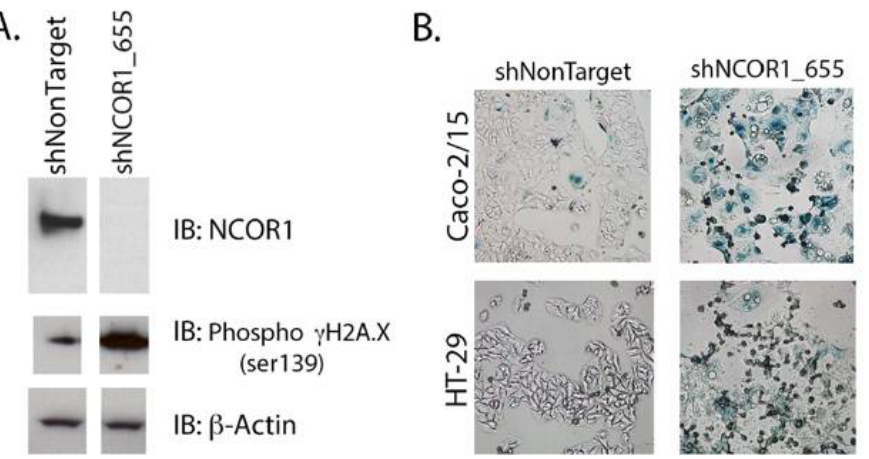
Figure 4. NCOR1 downregulation leads to cellular senescence in CRC cells. ( A ) Immunoblots were performed to detect NCOR1 protein and γ H2A.X serine 139 phosphorylation. Total protein extracts from Caco-2/15 cells expressing a control shRNA (shNonTarget) or shNCOR1_655 (7 days after infection) were used ( n = 3). The relative level of β -actin protein was monitored to control for protein loading. ( B ) SA β -galactosidase staining was performed on Caco-2/15 (3.5 h) and HT-29 (8.5 h) cells expressing either shNonTarget or shNCOR1_655, 7 days after